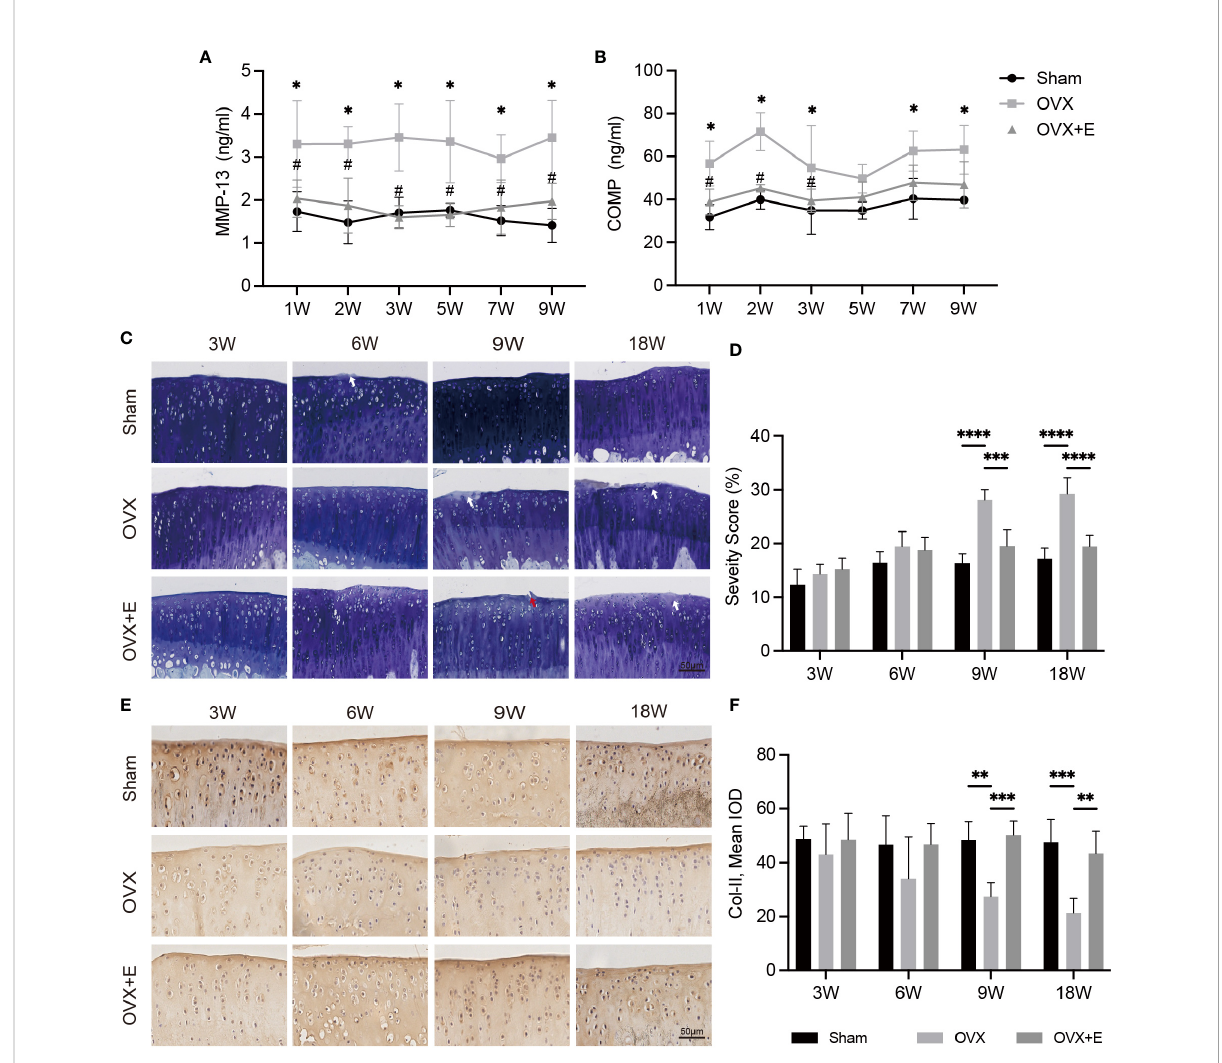
FIGURE 3 The change in cartilage degeneration after surgery from week 3 to week 18 in Sham, OVX and OVX+E rats. (A, B) The serum levels of MMP-13 and COMP (n = 7). *p< 0.05 vs. Sham group. #p< 0.05 vs. OVX group. (C) Toluidine blue staining in articular cartilage. The white arrow indicates proteoglycan loss. The red arrow represents the rough surface (n = 7). Scale bar, 50 m m. (D) Q uanti fi cation of cartilage surface erosion of tibial plateau cartilage. (E) Representative images of COL-II expression (n = 7). Scale bar, 50 m m. (F) Semiquantitation of COL-II expression. *p< 0.05, **p< 0.01, *p< 0.01, ***p< 0.001, ****p<